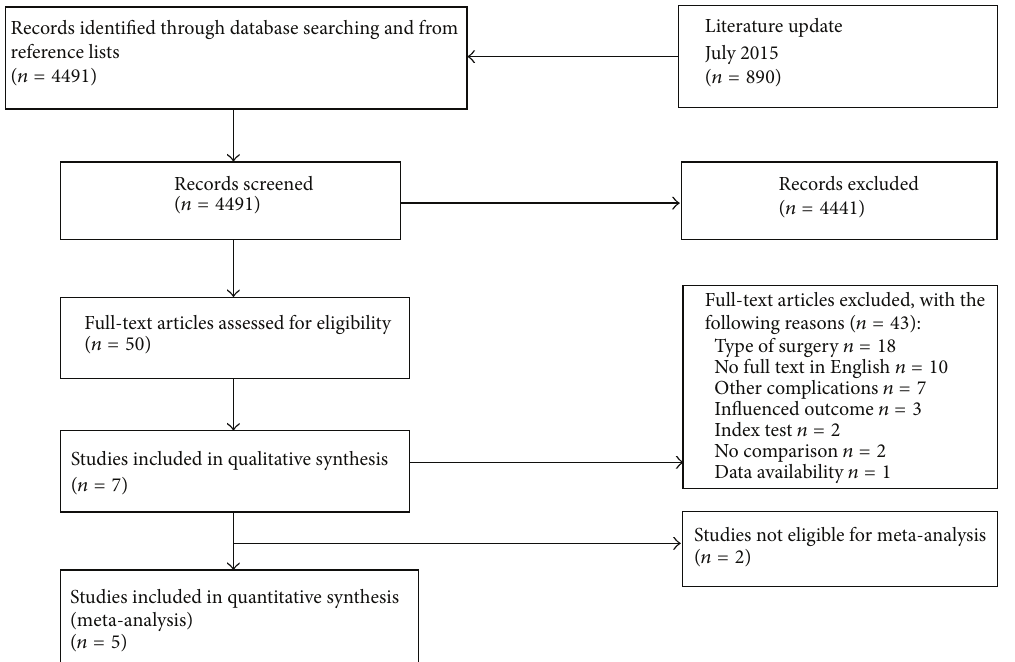
Figure 1: PRISMA flow chart representing selection of articles for